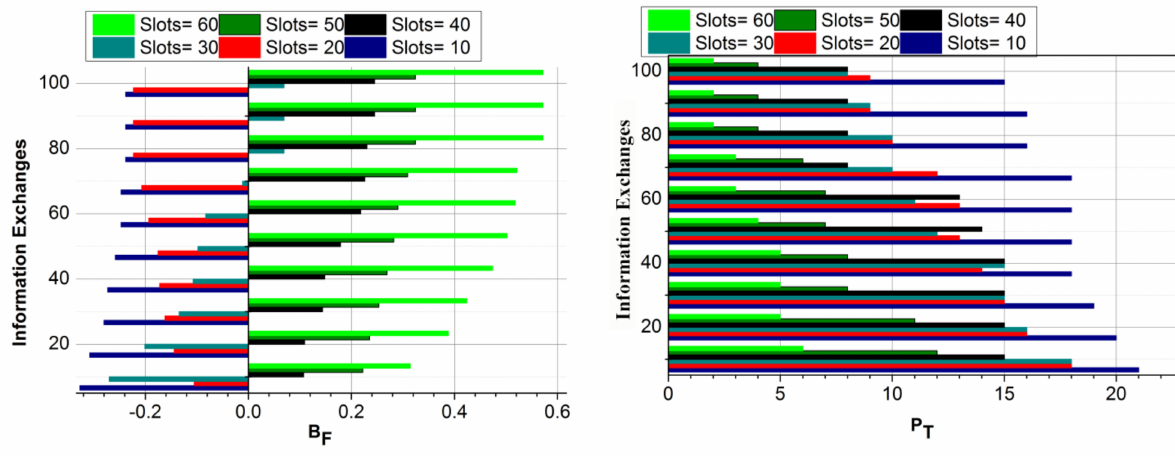
Figure 6. B F and P T